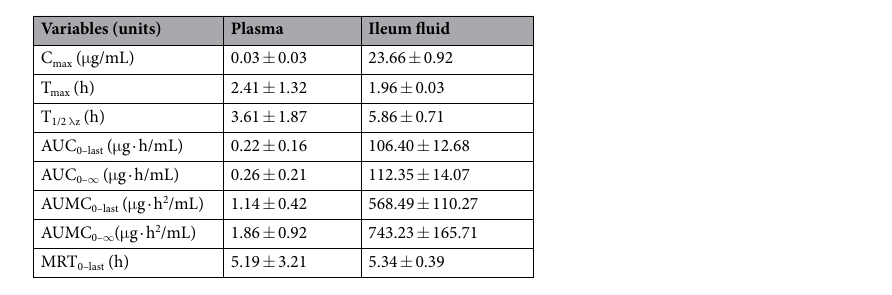
Table 2. Pharmacokinetic parameters of cyadox in plasma and ileum fluid (mean ± SD, n = 6). Notes: The pharmacokinetic parameters were calculated by non-compartment model.